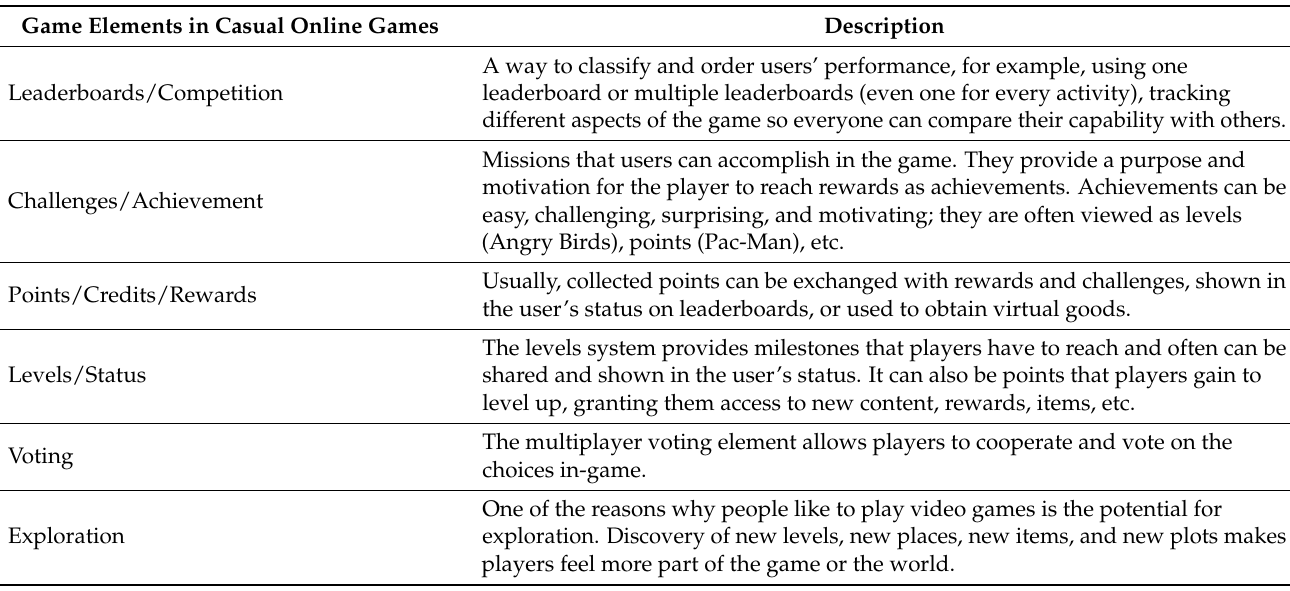
Table 1. Game elements in casual online games. Source: own